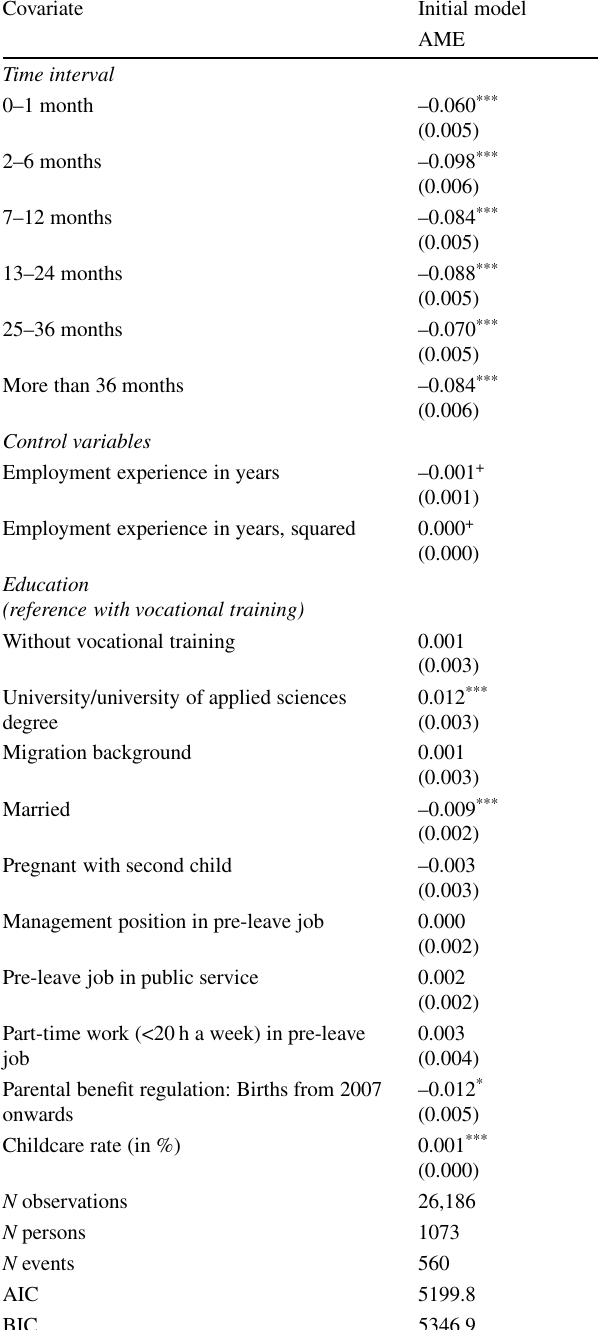
Table 3 Complementary log-log model to estimate the return probability – initial model. (Source: NEPS 1.0.0 2011, SIAB